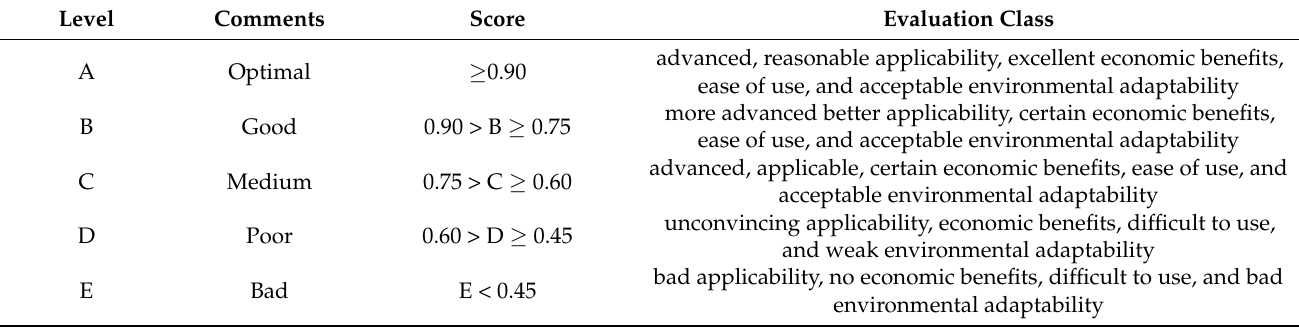
Table 2. Comprehensive evaluation grade.